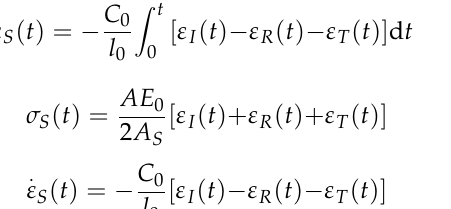
( c ) Figure 5. The waveforms of incident waves with different pulse shapers: ( a ) Stress time history curve, ( b ) Rubber sharper, ( c ) Brass sharper.